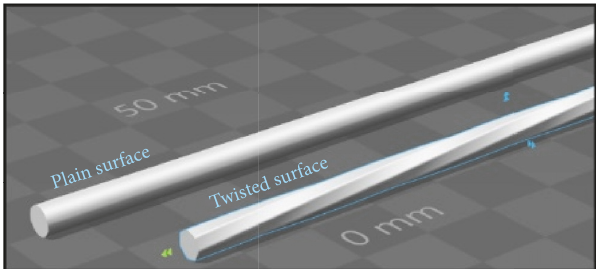
Figure 9: Simple 3D models of two types of geometrical surfaces printed to verify how the surface design can modify the photocatalytic experiments.